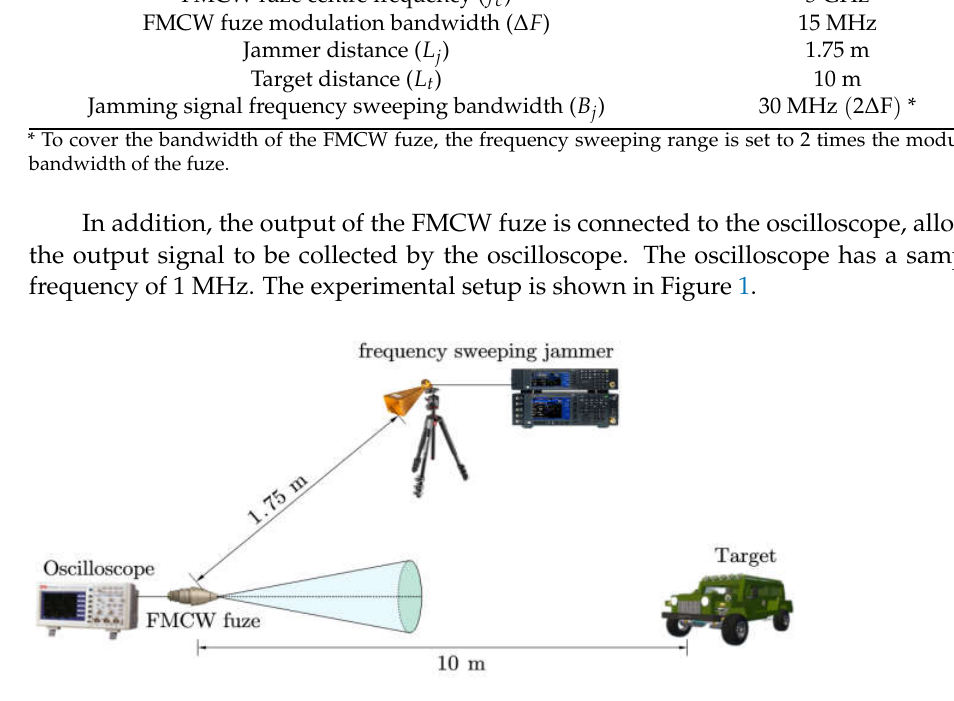
Figure 1. Experimental layout diagram.